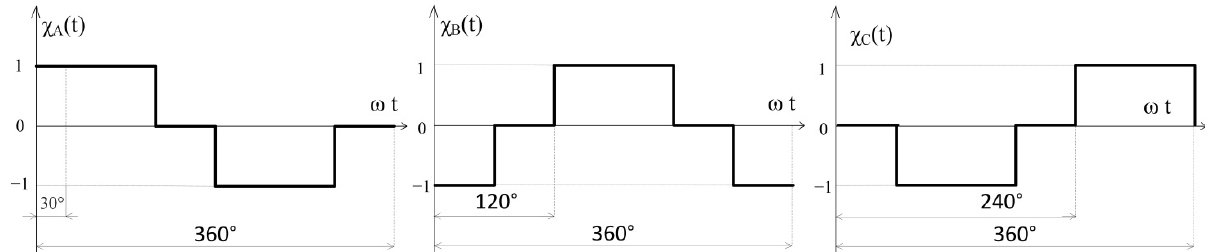
Figure 3. Conduction functions of VSI phases.